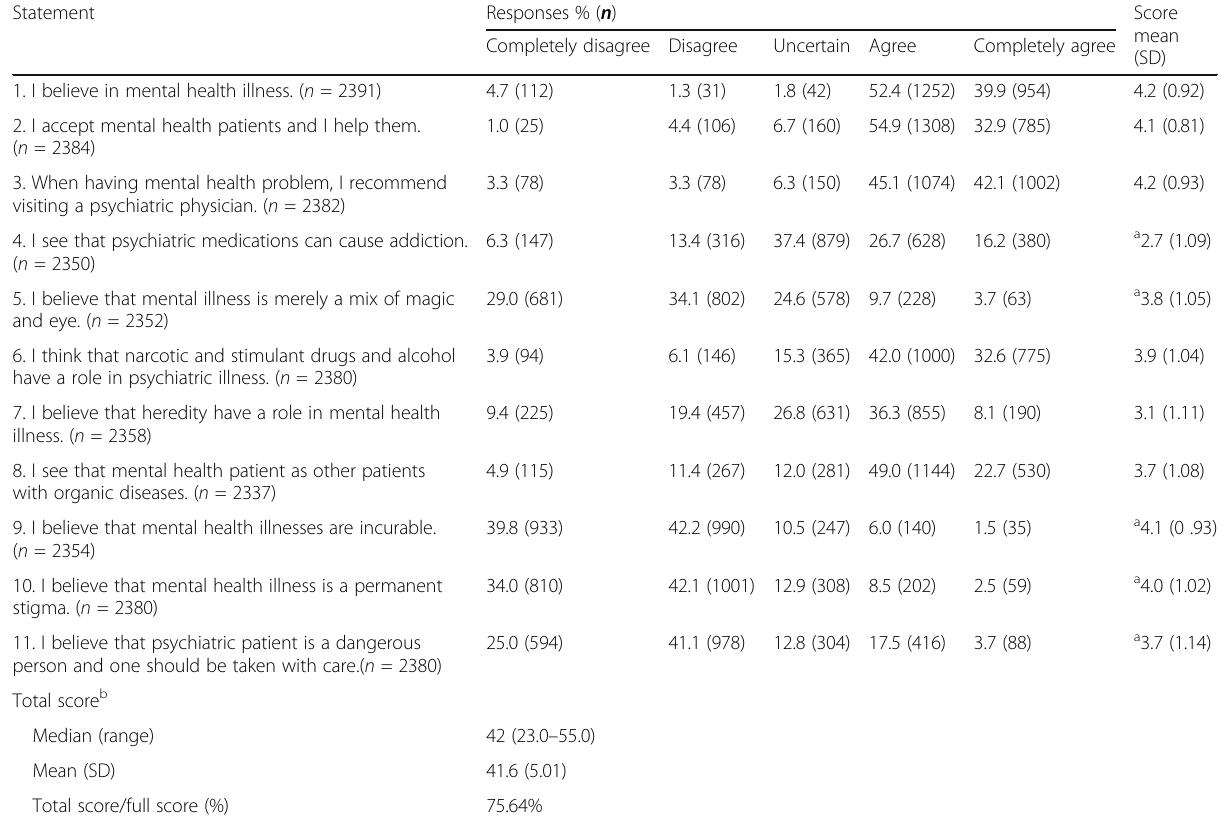
Table 3 Teachers ’ attitude towards students ’ mental health issues Statement Responses % ( n